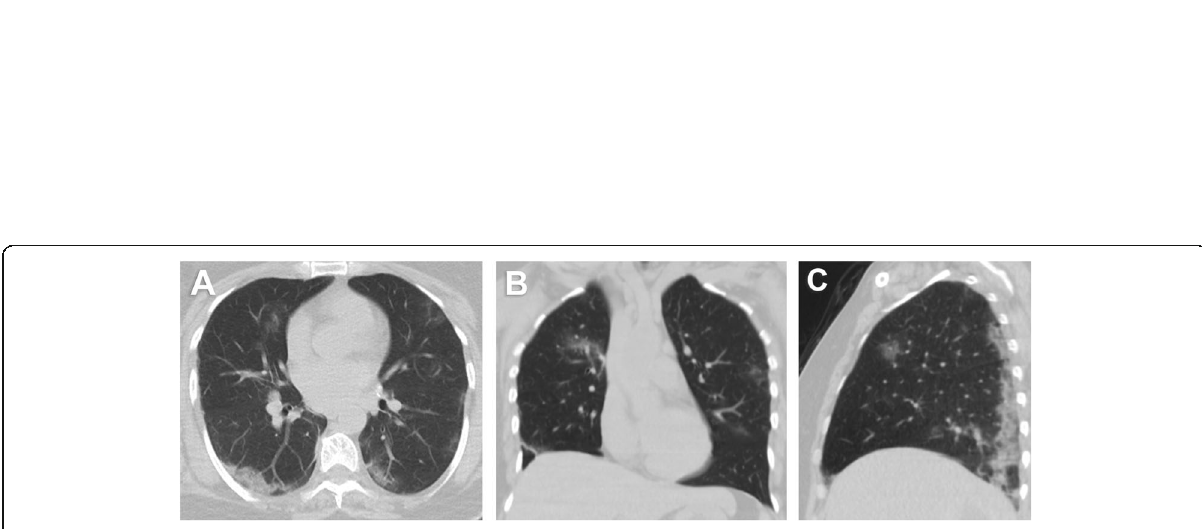
Fig. 5 A 50-year-old female patient. A axial, B coronal, and C sagittal chest CT images show bilateral peripheral ground-glass opacities and consolidation with mild pulmonary involvement (5 – 25%) corresponds to current chest CT score 8 and simple chest CT score 2 (mild affection). The patient